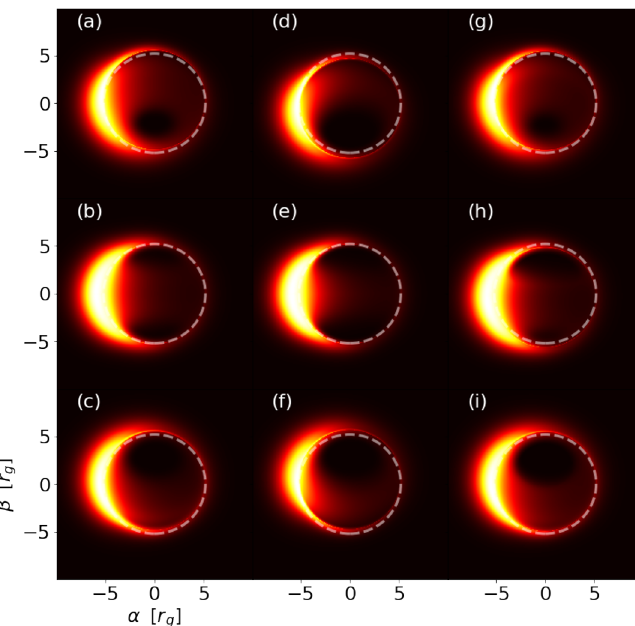
Figure 11 . Examples of black hole images when supertranslated black holes are surrounded by optically thin and geometrically thick accretion flows. The corresponding soft-hair parameters and inclination angle are the same as in figure 6, while the field of view is slightly larger. For reference, the boundary of the shadow for a Schwarzschild black hole is indicated by the dashed white circles. Keeping the same flow dynamics and emission details of the flow, the plots demonstrate that how the resulting image can be affected by detailed radiative transfer process along different geodesics in CLI metrics with different soft-hair perturbations. In each plots, due to the rotation of the accretion flow, the approaching side (left side of each plot) of the flow is brighter than that of the receding side (right side of each